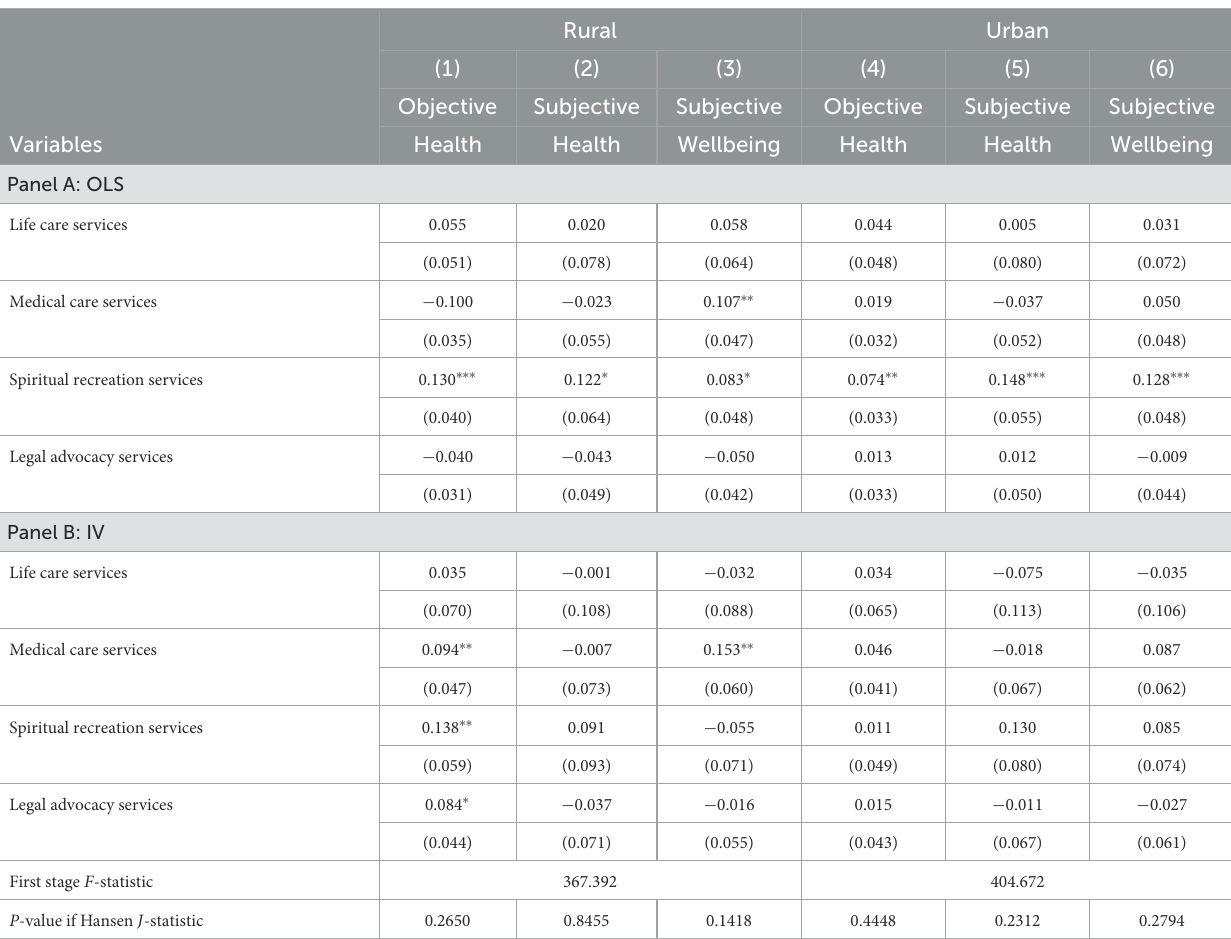
TABLE 6 Heterogeneous effect by